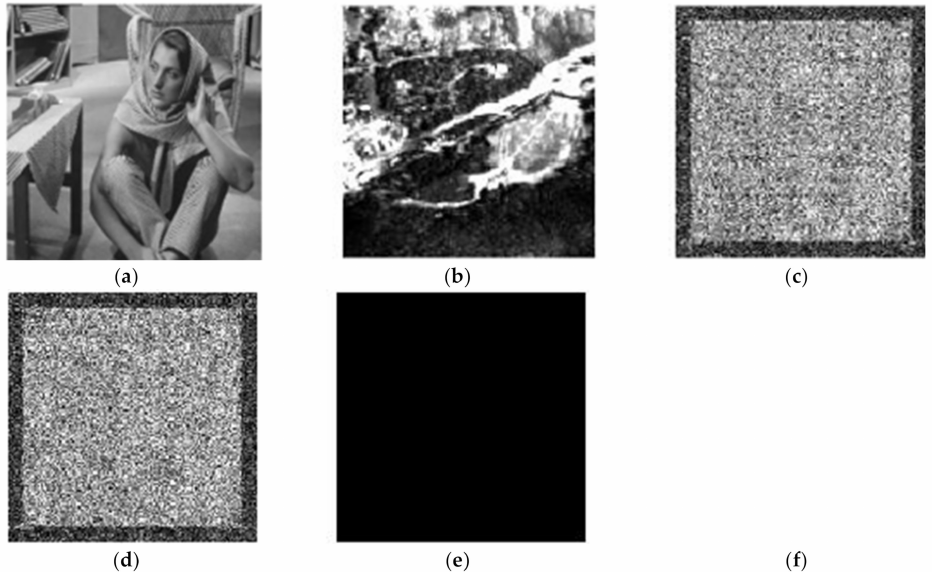
Figure 13. The test of known plaintext attack and chosen plaintext: ( a ) the secret image; ( b ) the secret image; ( c ) the encrypted data of ( a ); ( d ) the encrypted data of ( b ); ( e ) the result of known plaintext attack; and ( f ) the result of chosen plaintext